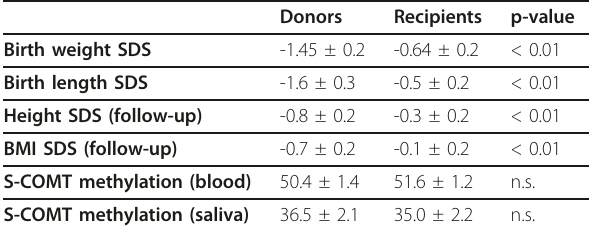
Table 4 Auxiological and epigenetic differences between donors and recipients (mean ± SEM)